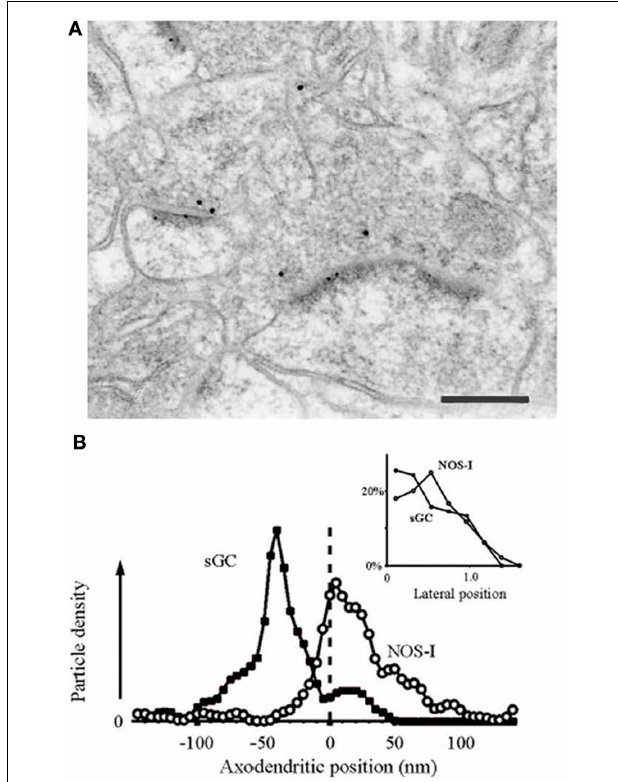
FIGURE 4 | NOS1 positive spines and sGC positive terminals in the hippocampus. (A) Positions of gold particles identifying NOSI and sGC located within 150nm of the post-synaptic membrane. Inset, labeling close to the plasma membrane is concentrated at the synaptic specialization for both antigens. (B) Double immunogold labeling showing that NOS1-positive PSDs lie post-synaptic to sGC-positive axon terminals. Small dots are 5nm gold particles labeling NOS1. Large dots are 10nm gold particles labeling sGC β . Scale bar is 200nm. Adapted from Burette et al. (2002) with kind permission of the authors and the Society for